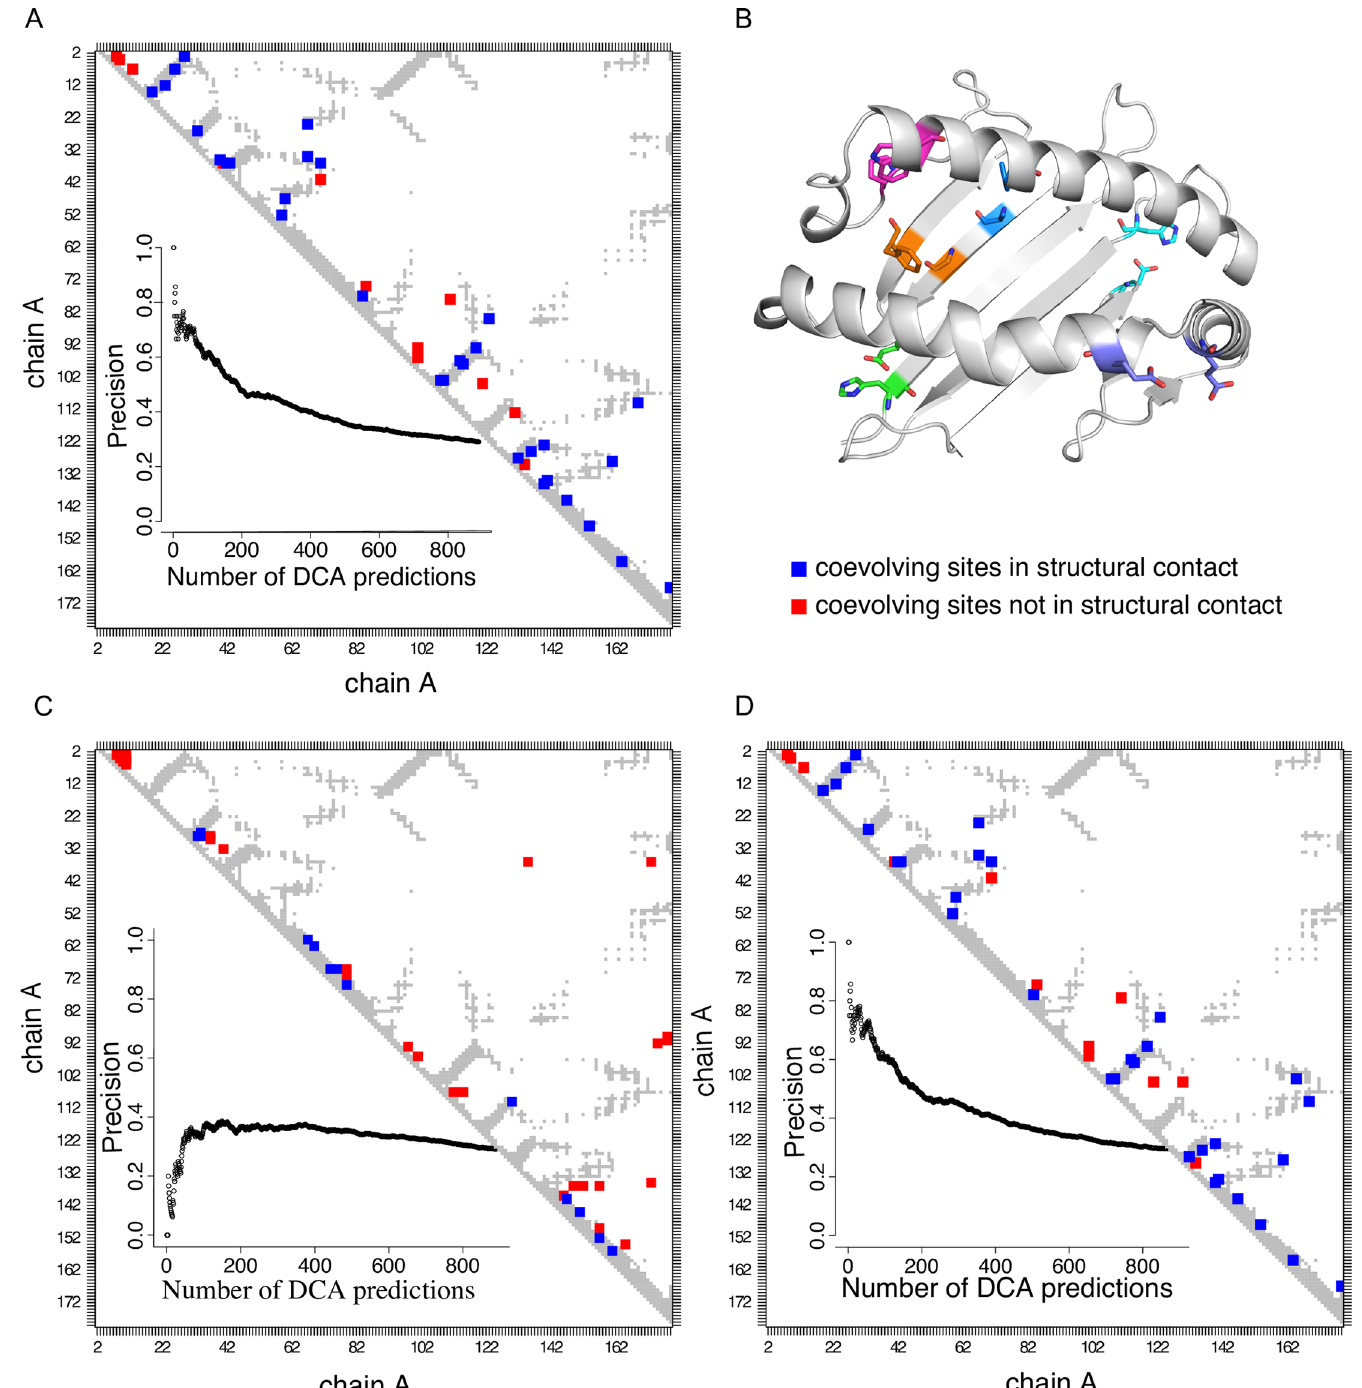
Fig 2. Inter- but not intra-species co-evolution accurately predicts structural contacts for MHC-I molecules. A. Contact map based on HLA-A02:01 structure (PDB: 2BNR, pairs of residues at distance < 8A are shown in grey) summarizing DCA predictions (top 44) with all vertebrate MHC-I sequences (see Materials and Methods). Blue squares represent structurally close pairs of sites predicted by DCA and red squares represent structurally distant pairs of sites predicted by DCA. The inset shows the precision (number of true positives divided by total number of predictions) for different numbers of DCA predictions (see Materials and Methods). B. Three- dimensional structure of HLA-A02:01 allele (PDB: 2BNR). The top six DCA predictions of co-evolving pairs of amino acids are displayed with different colours. C. Same data as in B, but restricting DCA predictions to human MHC-I sequences. D. Same data as in B, but restricting DCA predictions to non-human MHC-I vertebrate